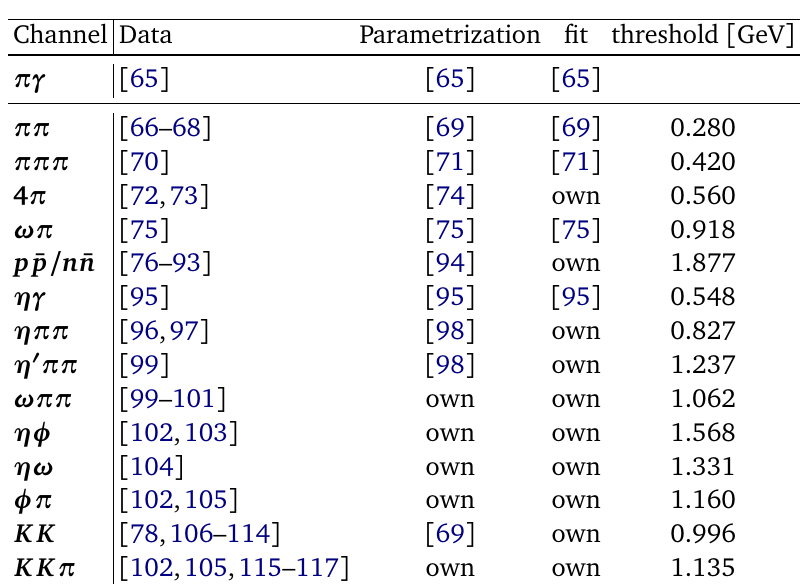
Table 2: Dominant processes contributing to e + e − → hadrons in the relevant energy